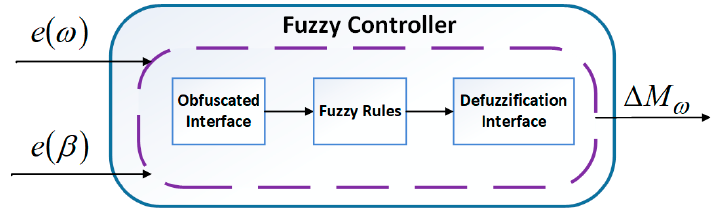
Figure 10. Compensated yaw moment controller.